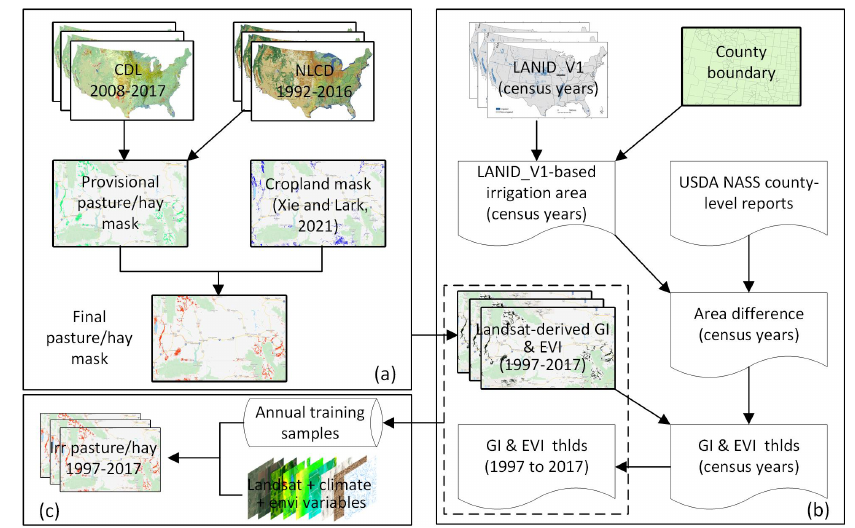
Figure 1. Flowchart of mapping irrigated pasture and hay in western US (a) generating the maximum extent of pasture–hay, (b) creating training samples, and (c) classification. Cropland mask refers to the maximum extent of non-pasture–hay cultivated land created in Xie and Lark